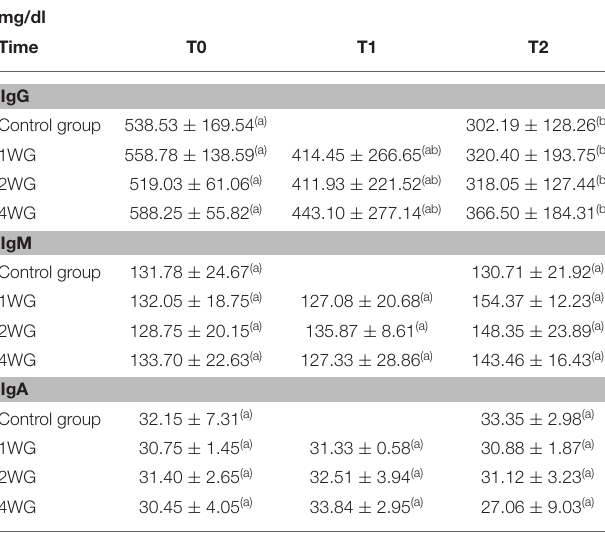
TABLE 2 | Ig concentration in serum of bitches enrolled in the 4 study groups at T0, T1, and T2.